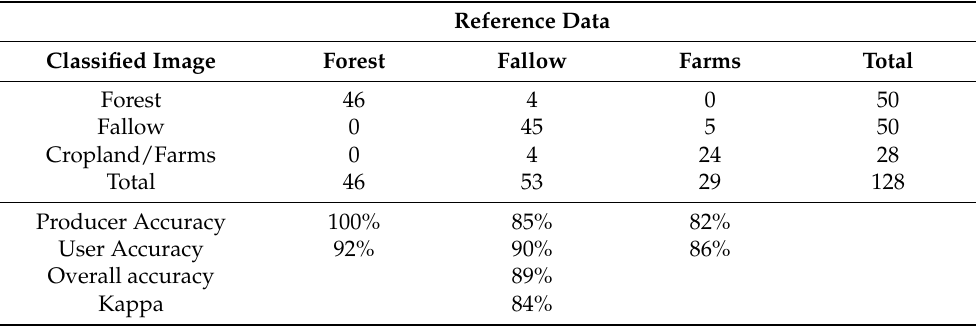
Table 4. Cross-tabulation error matrix of a classified image versus reference data for